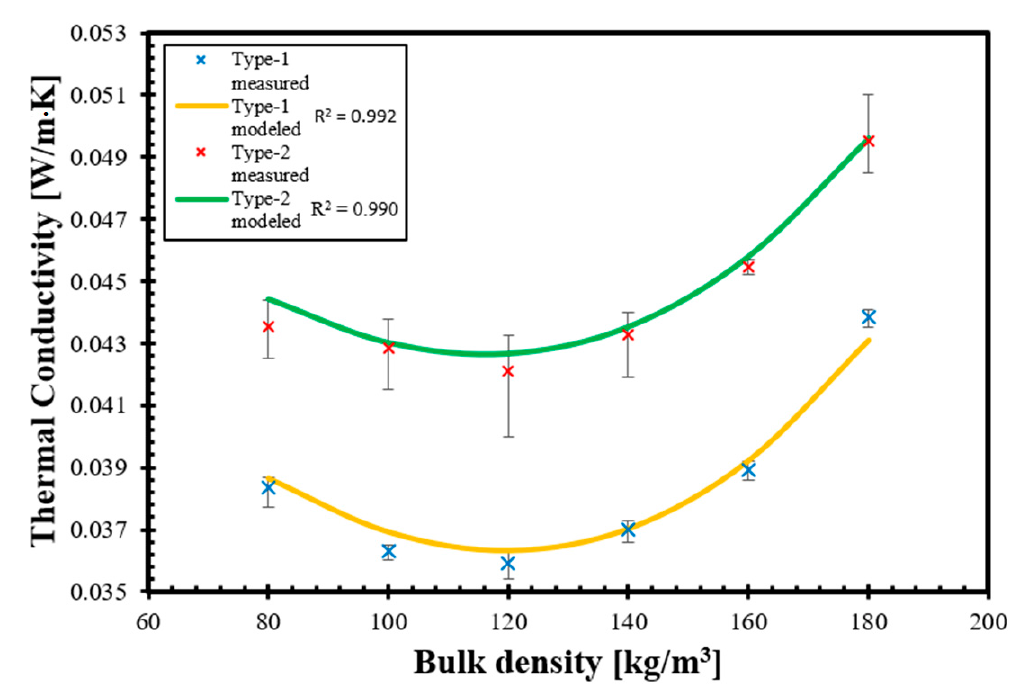
Figure 10. Relationship between bulk density and total thermal conductivity in case of the results of laboratory measurements and the analytic-empirical model using Type-1 and Type-2 straws.